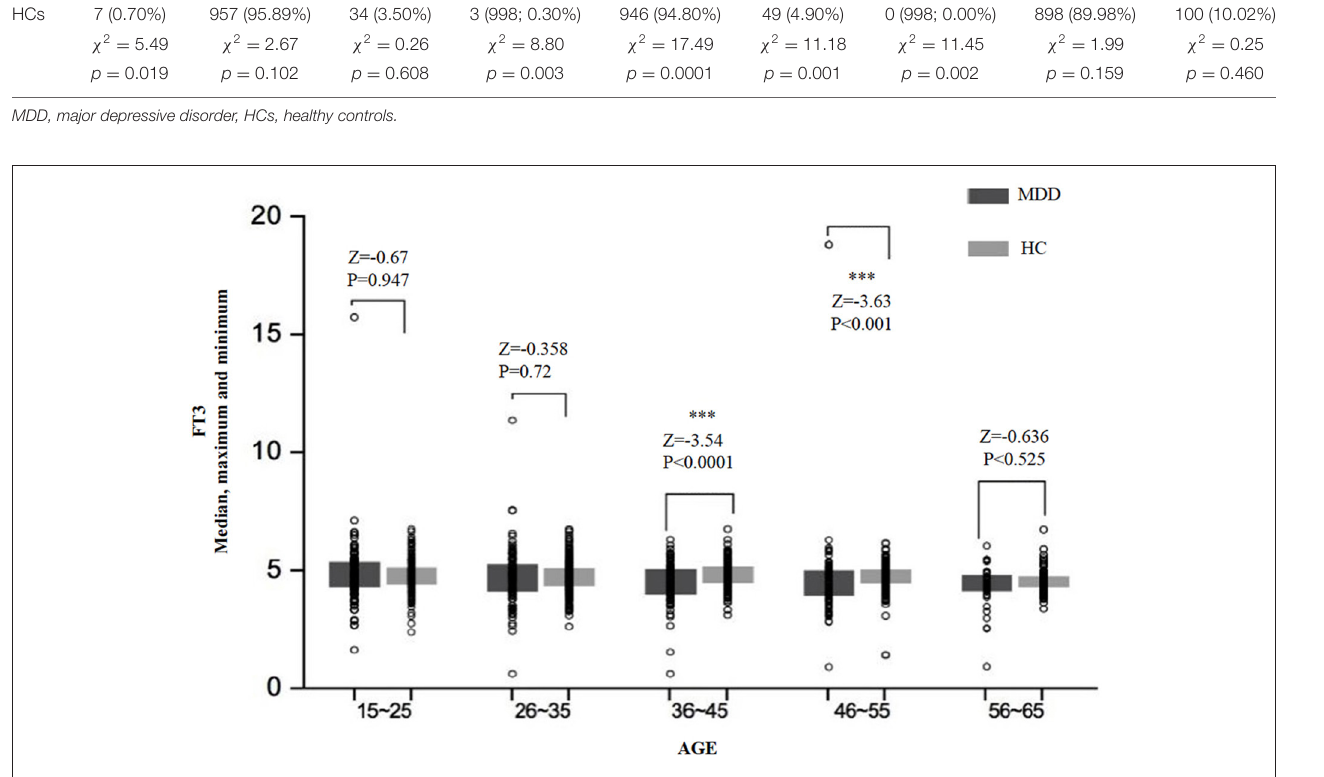
p = 0.008) and the HC group ( H = 7.28, df = 4,